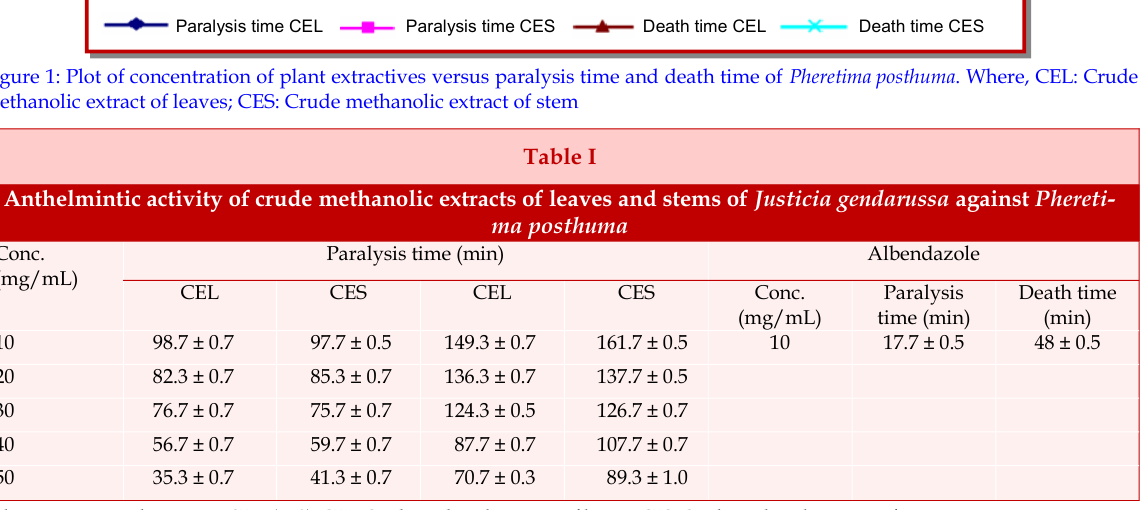
Figure 1: Plot of concentration of plant extractives versus paralysis time and death time of Pheretima posthuma . Where, CEL: Crude methanolic extract of leaves; CES: Crude methanolic extract of stem